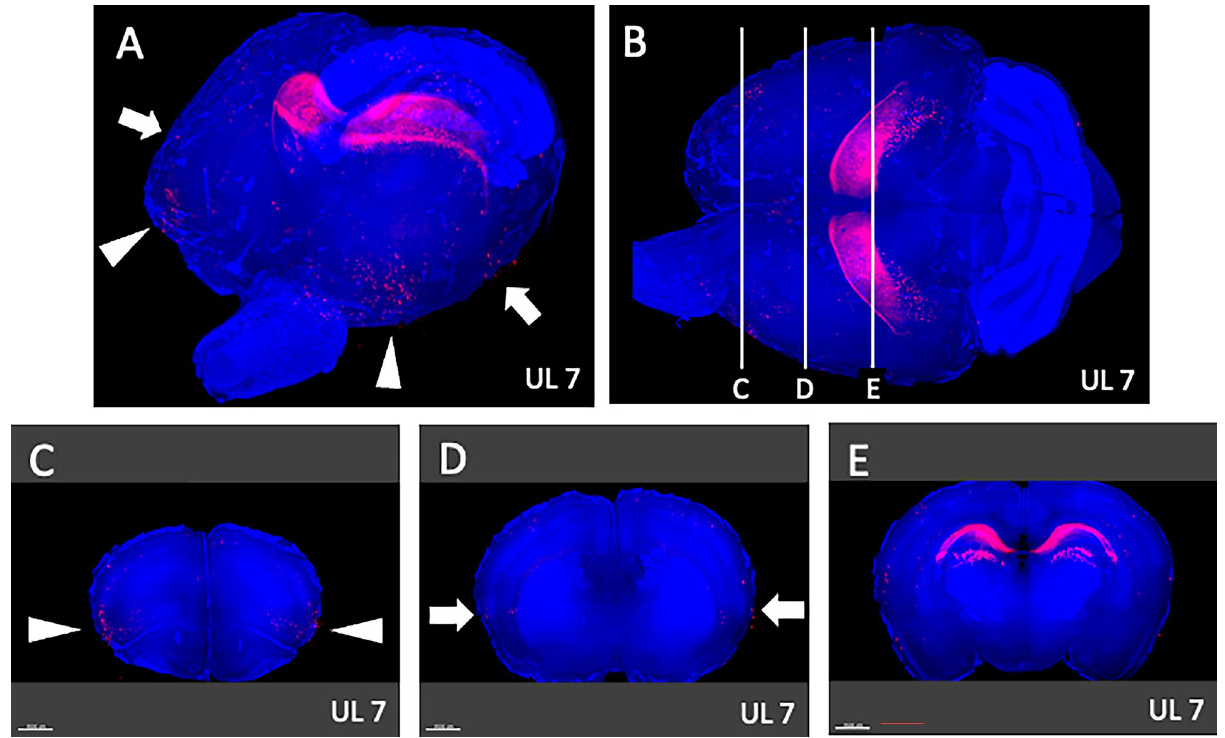
Figure 10. Survey on arbitrary cross sections on UL7. ( A ) Panoramic view of whole-brain imaging on day 7 after UL. Neural activity can be observed in the anterior-temporal (arrowheads) and temporal (arrows) regions. ( B ) Images from the top of the brain. The vertical lines indicate the cross-sectional positions in panels ( C – E ). ( C ) The activated neurons in the anterior temporal region (arrowheads, panel A ) are located in the agranular insular cortex (AIC) (arrowheads). ( D ) Activated neurons in the temporal region (arrows, panel A ) were located in the primary somatosensory cortex (S1). ( E ) Activated neurons observed in the caudate putamen on day 2 were decreased on day 7 after UL. Activated neurons in the caudate putamen were not observed.